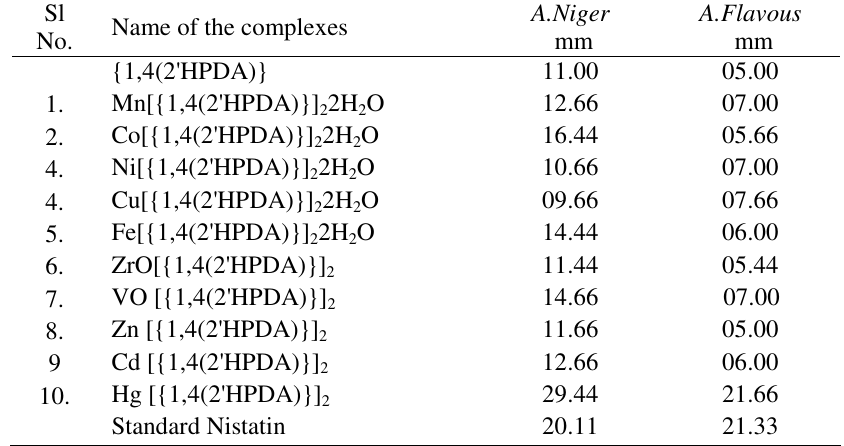
Table 4. Antifungal Activities of various synthesized metal {1,4(2'HPDA)} complexes: